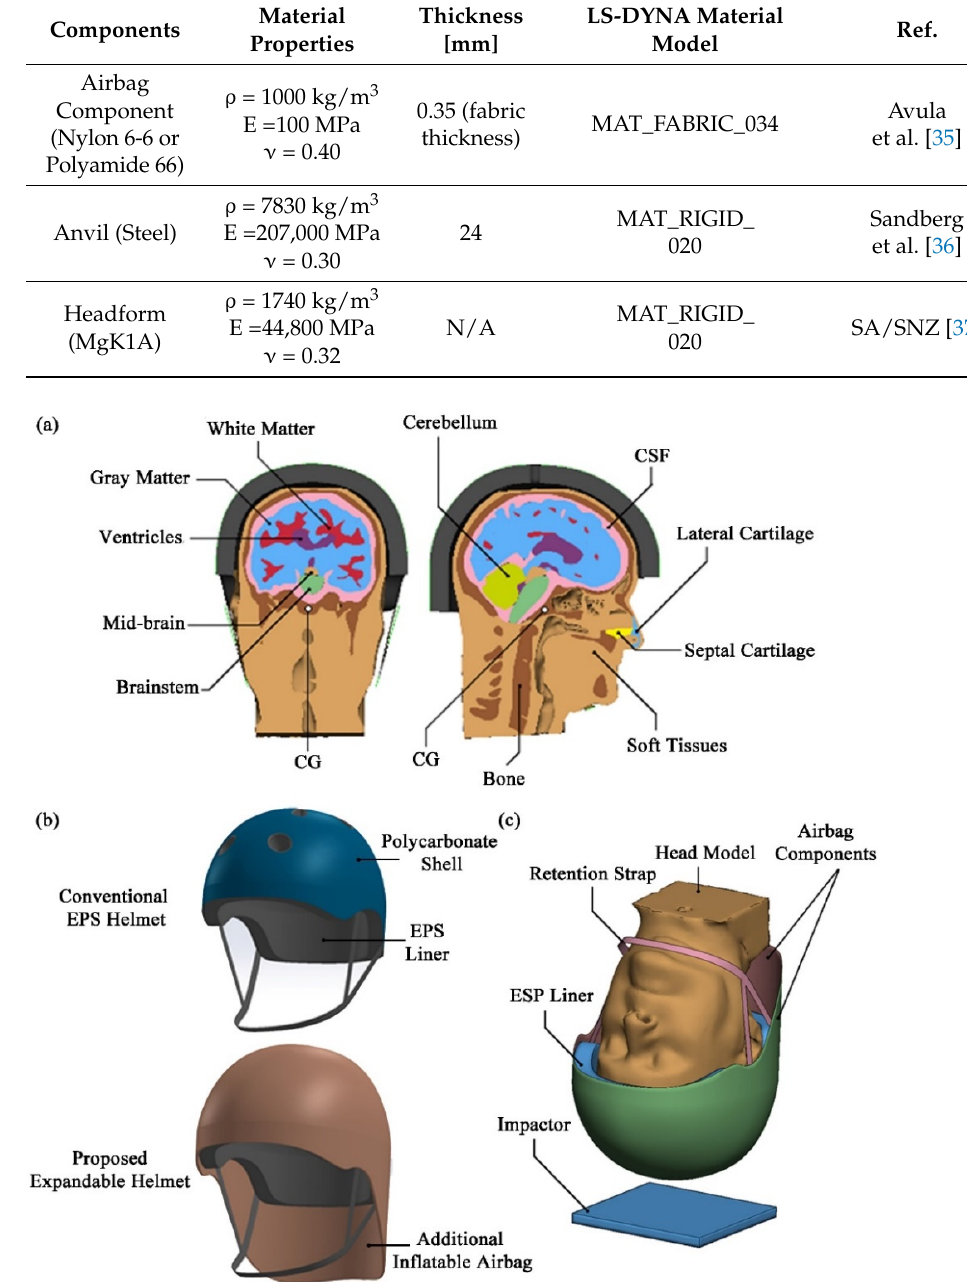
Figure 1. ( a ) Various components of the head model; ( b ) the exemplary conventional EPS helmet and expandable helmet; ( c ) various components of the expandable helmet model in the impact scenario in accordance with EN 1078 standard (1997). Table 2. Material properties of various components in the airbag–helmet–headform model.